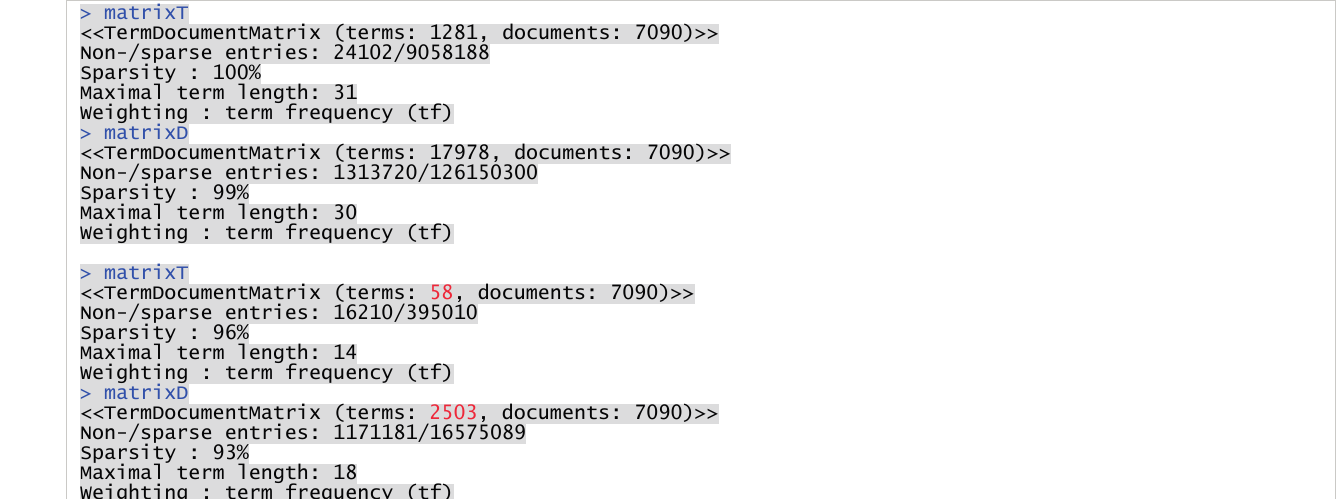
Figure 2. JobTitle and JobDescription matrices (before and after sparse terms